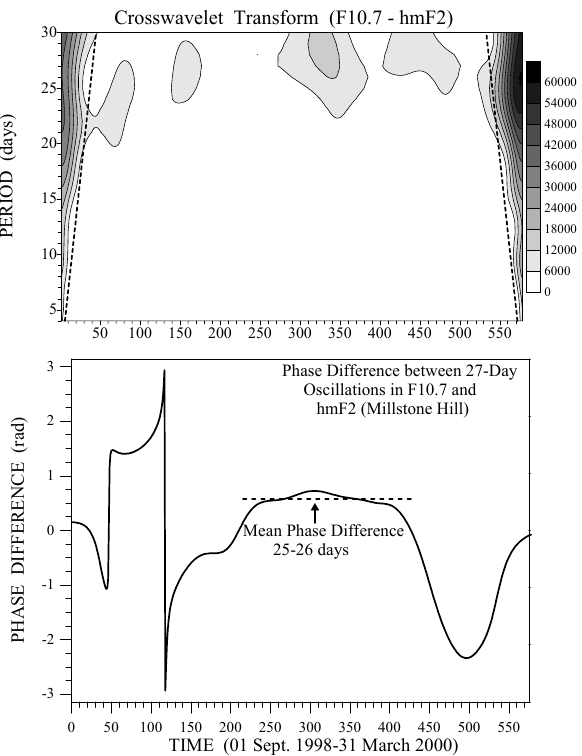
Fig. 6. The same as Fig. 5, but between the solar radio flux F10.7 and hm F2.